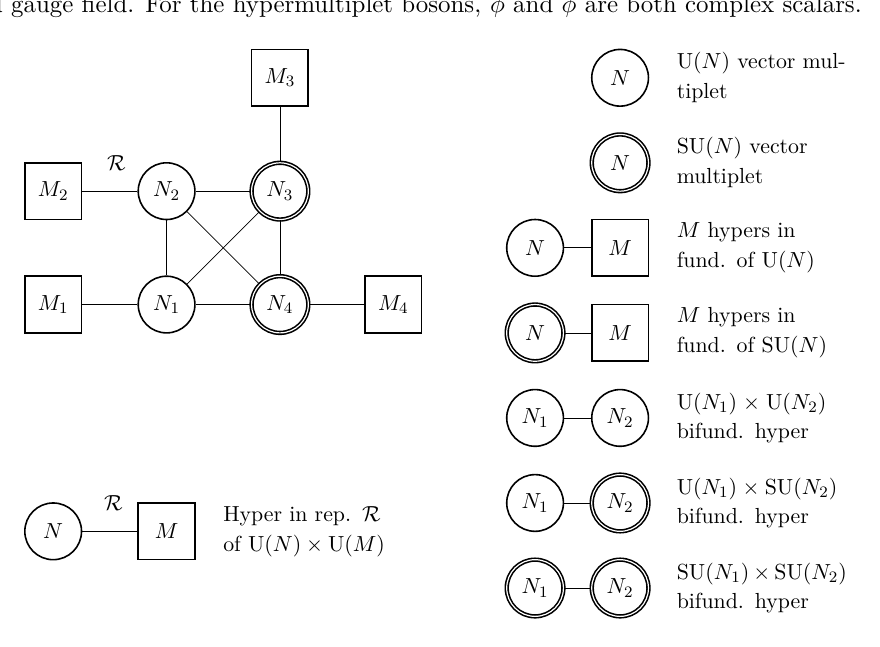
Figure 2 . L.h.s.: a quiver diagram representing the field content of a 3d N = 4 theory with gauge group G = U( N ) × U( N ) × SU( N ) × SU( N ) , and fundamental/bifundamental matter. The 1 2 3 4 various conventions are listed on the r.h.s. In a quiver diagram, we will refer to the circles as gauge nodes and the boxes as flavor